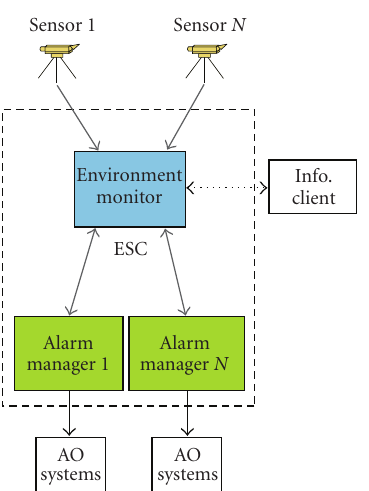
Figure 2: Main elements composing the ECS. The external blocks are: the sensors where data are collected, the di ff erent clients that request weather data to the EM, and the di ff erent systems that need to receive the alarms. AO stands for Astronomical